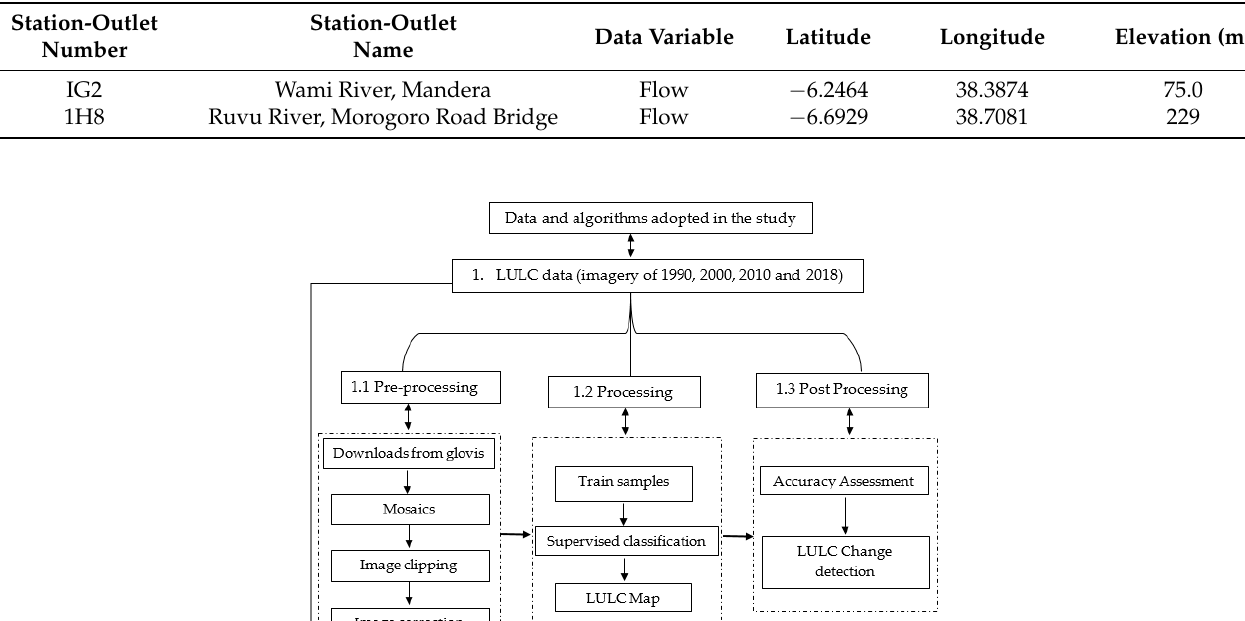
Table 4. The station-outlets used for the SWAT model calibration and validation.